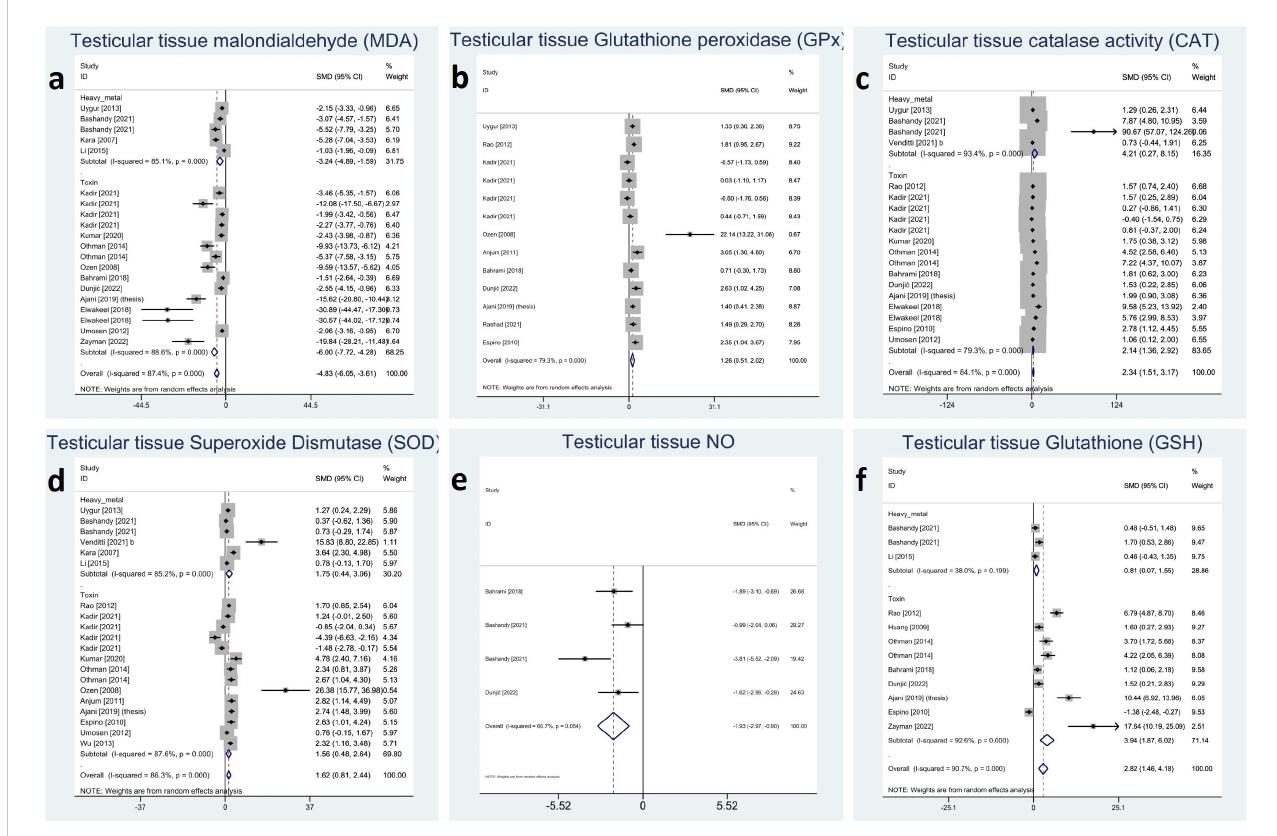
FIGURE 6 Forest plots for overall and subgroup effect measures on the impact of melatonin therapy on the testicular tissue level of oxidative stress markers including (A) MDA, (B) GPx, (C) CAT, (D) SOD, (E) NO, (F) GSH. MDA, Malondialdehyde; GPx, Glutathione Peroxidase; CAT, Catalase; SOD, Superoxide Dismutase; NO, Nitric Oxide; GSH,